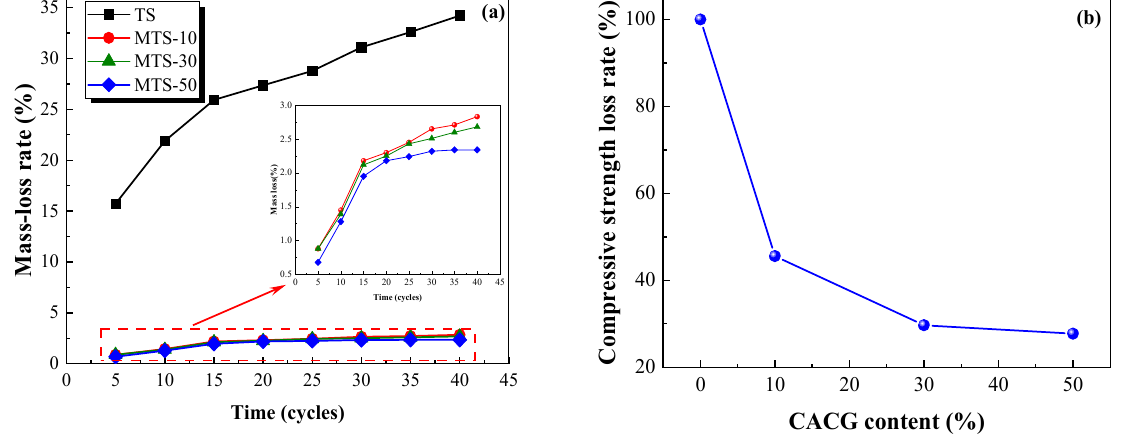
Figure 16. Mass loss rate ( a ) and compressive strength loss rate ( b ) in different freeze–thaw cycles.